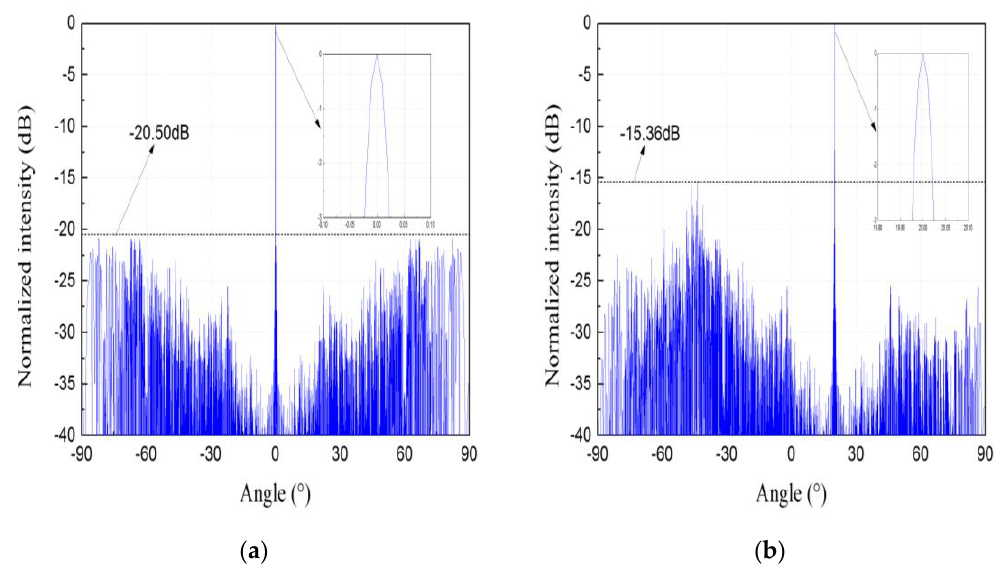
Figure 4. The far field patterns of the nonuniform array with 1024 antennas, when the steering angle θ s is ( a ) 0° and ( b ) 20°, respectively.